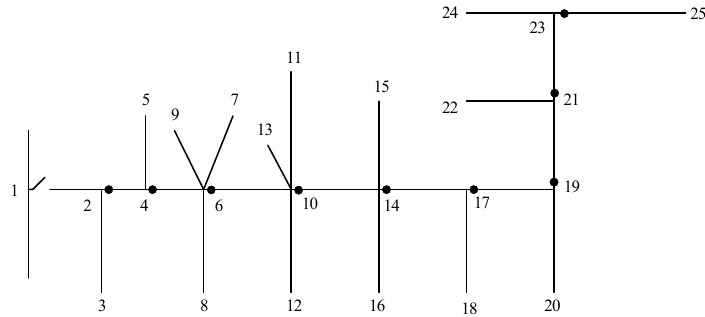
Figure 6. Example 1: alternative switch-position map (no contact).